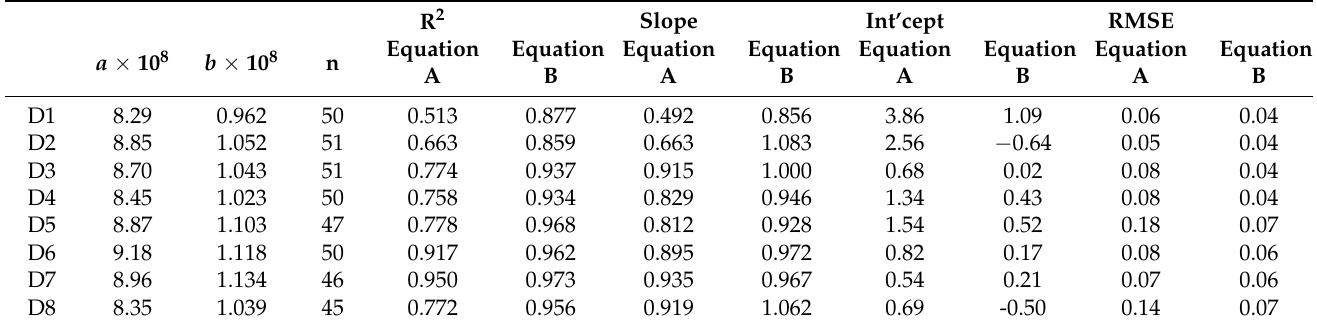
Figure 5, with equivalent graphs for D1, D3, D5, and D7 in Figure A7 in Appendix A. Coefficient values for Equations A and B and statistical data for all digesters are given in Table 5. Table 5. Coefficient values and statistical parameters from the application of Equations A and B to data series from day 25–100 of experimental